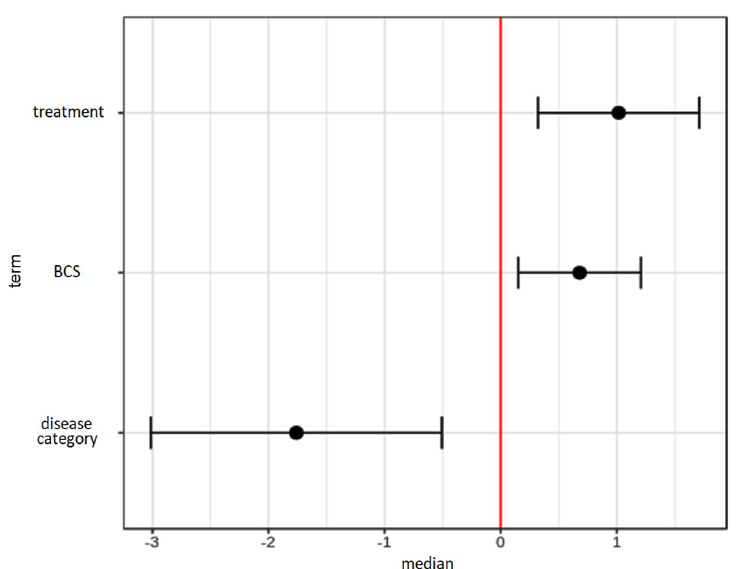
Fig 3. Effect of selected variables on variance of the phospholipid profile on PC2 in whole blood. Fixed effects are plotted with 95% confidence intervals. Treatment, body condition score (BCS), and disease category do not overlap with 0, thus representing significant factors on the variance of the phospholipid composition (ANOVA p < 0.05).